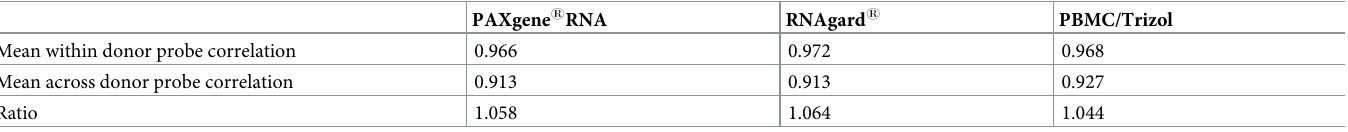
Table 1. Comparison of within and across donor probe M value correlations using three different blood collection